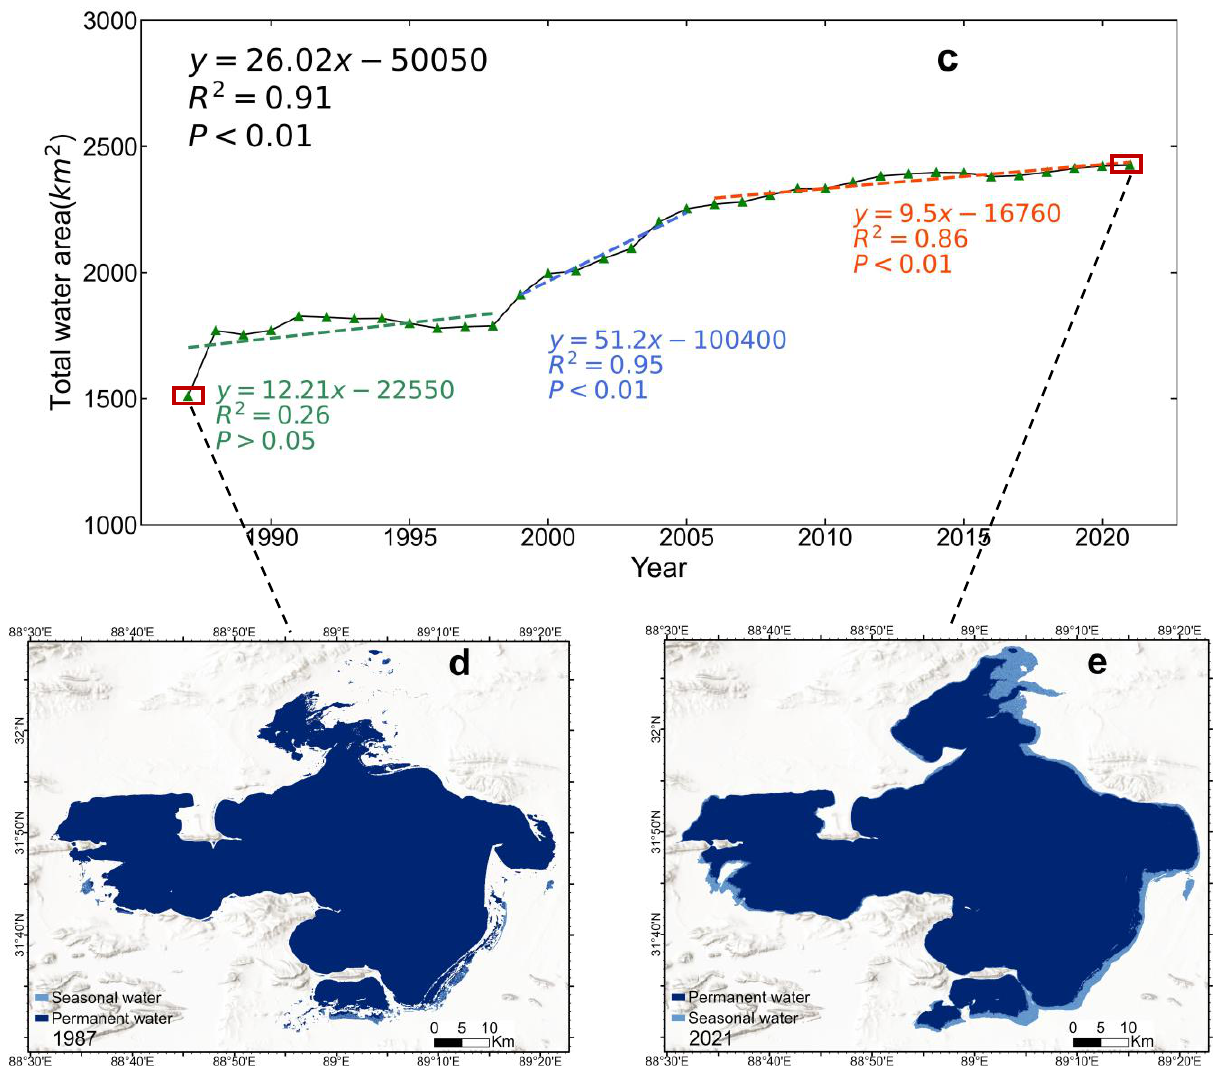
Figure 8. Time-series changes in the water area of Seling Co Lake. Panel ( a ) shows the temporal changes in the permanent water area from 1987 to 2021; panel ( b ) shows the seasonal water area changes; panel ( c ) shows the total water area of Selling Co Lake; and panels ( d , e ) show the spatial distributions of the permanent and seasonal water areas in 1987 and 2021, respectively.